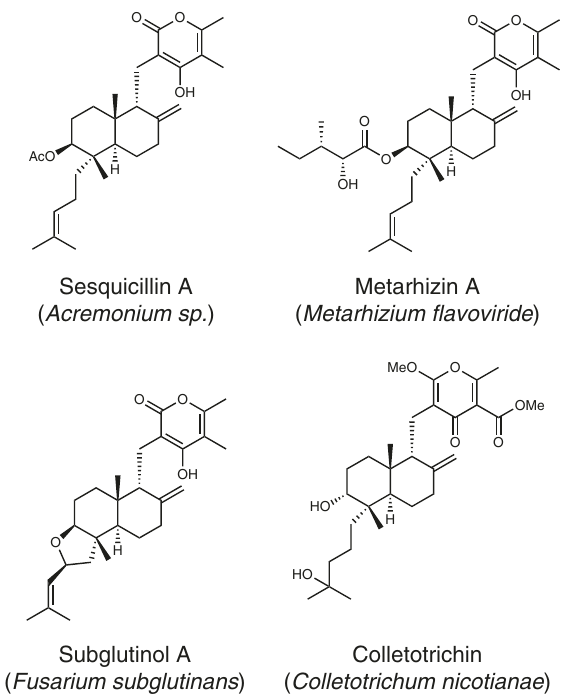
Fig. 2 Examples of fungal decalin-containing diterpenoid pyrones (DDPs). DDPs have two privileged structures, pyrone (PKS) and decalin (terpenoid), and show a wide range of biological